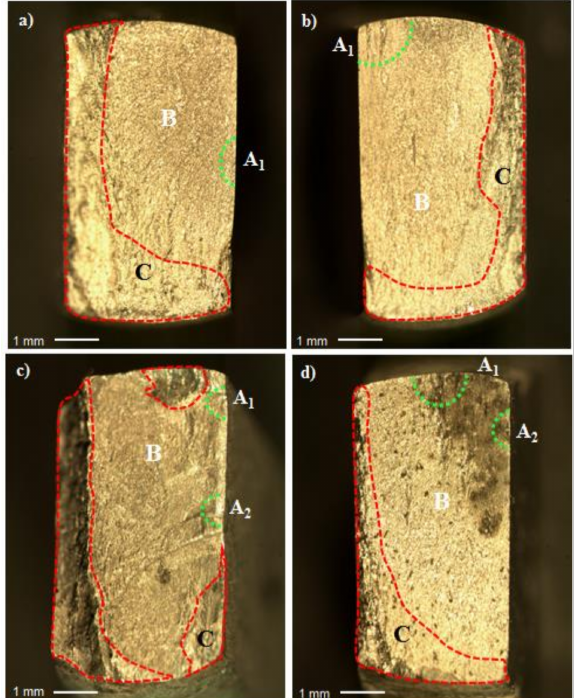
Figure 9. Optical stereo-micrographs of the AZ31B alloy: ( a ) polished (air; 167.5 MPa); ( b ) anodized (air—105 MPa); ( c ) polished (PBS solution—140 MPa); and ( d ) anodized (PBS solution—92.5 MPa). Marks on the micrographs represent the following fracture regions: (A 1 and A 2 ) crack initiation; (B) crack propagation; (C) catastrophic